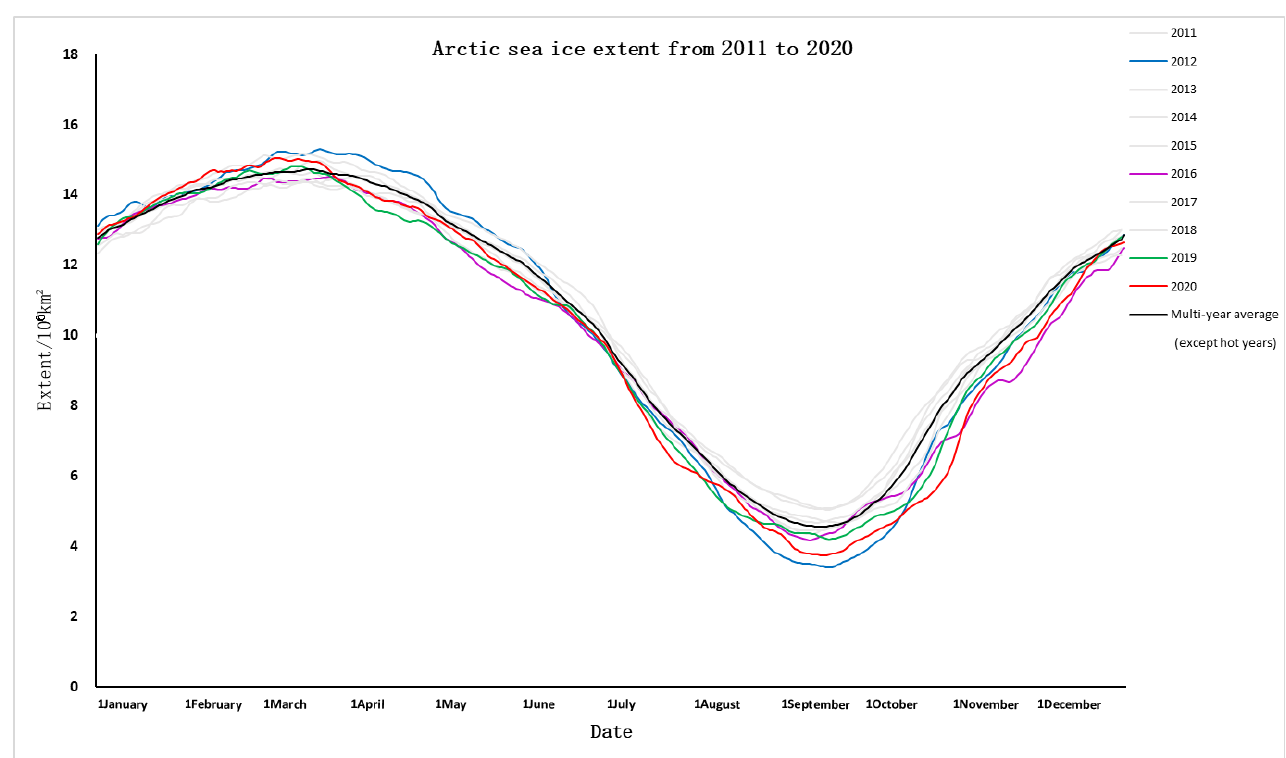
Figure 3. The extent of sea ice in the Arctic from 2011 to 2020.